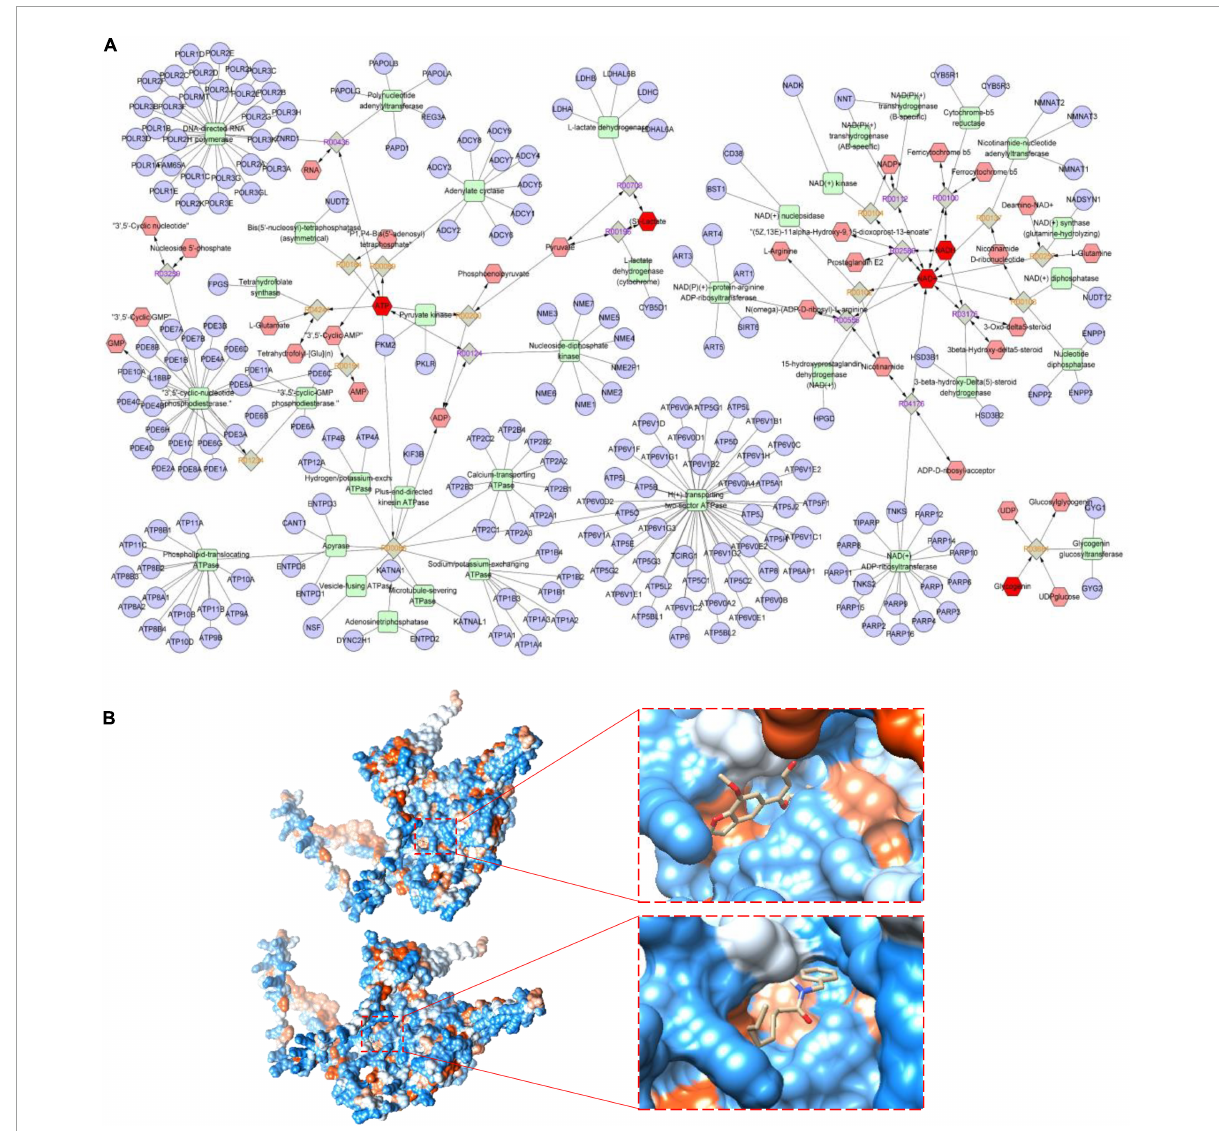
FIGURE7 Metabolic pathways and molecular docking. (A) Potential metabolic network regulated by Maca compound preparation (MCP) in exercising mice. The purple circular nodes represent genes, the green square nodes represent metabolism-related enzymes, and the red hexagon nodes represent fatigue-related metabolites, involving blood lactic acid (BLA), blood sugar, glycogen, adenosine triphosphate (ATP), and nicotinamide adenine dinucleotide (reduce) [NAD(H)] determined in exercising mice. (B) Molecular docking of cnidilin ( (cid:77) G = − 6.36 kcal/mol) and obacunone ( (cid:77) G = − 6.11 kcal/mol) to the key protein of the intestine-specific expression of phosphodiesterase 9A